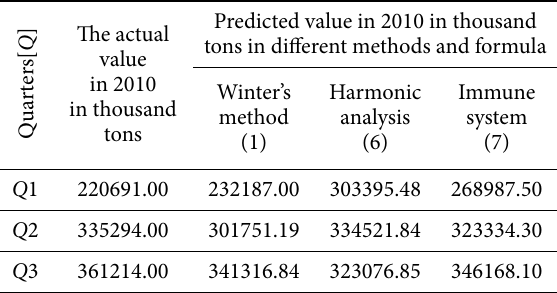
Table 4. Comparison between the real and predicted value of road transport in